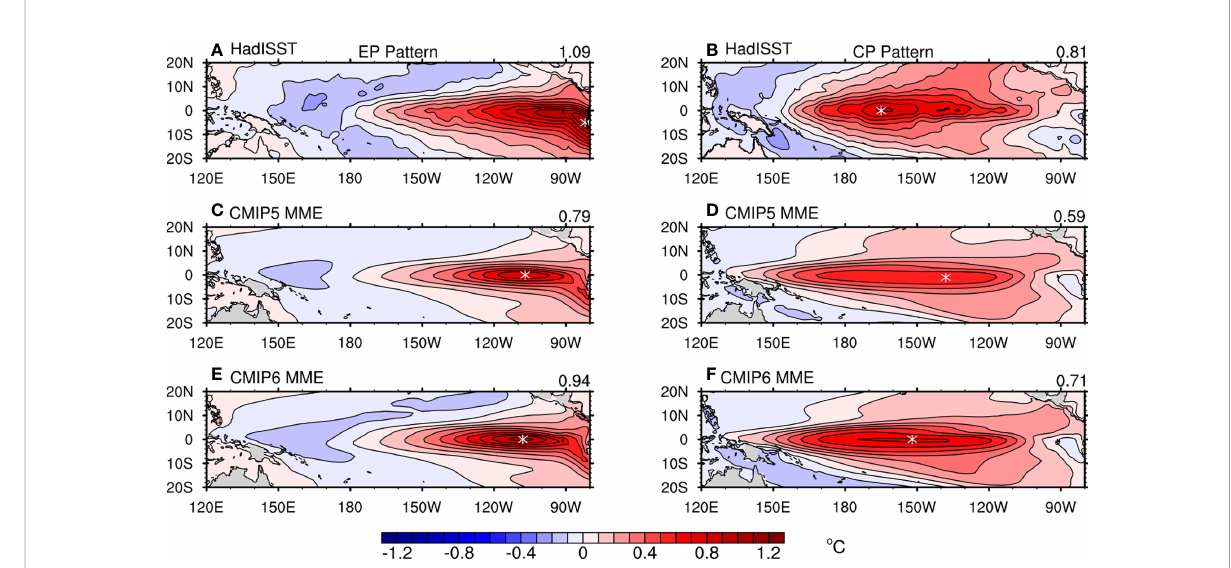
FIGURE 1 Spatial pattern of the standard deviations of the fi rst EOF mode for the EP ENSO and CP ENSO obtained from observations (A, B) . And the composite EP ENSO and CP ENSO spatial pattern of the multi-model mean of CMIP5 (C, D) and CMIP6 (E, F) . Asterisk markers denote the location of the maximum SSTA in each plot. The number on the top right of each plot represents the maximum SSTA value.